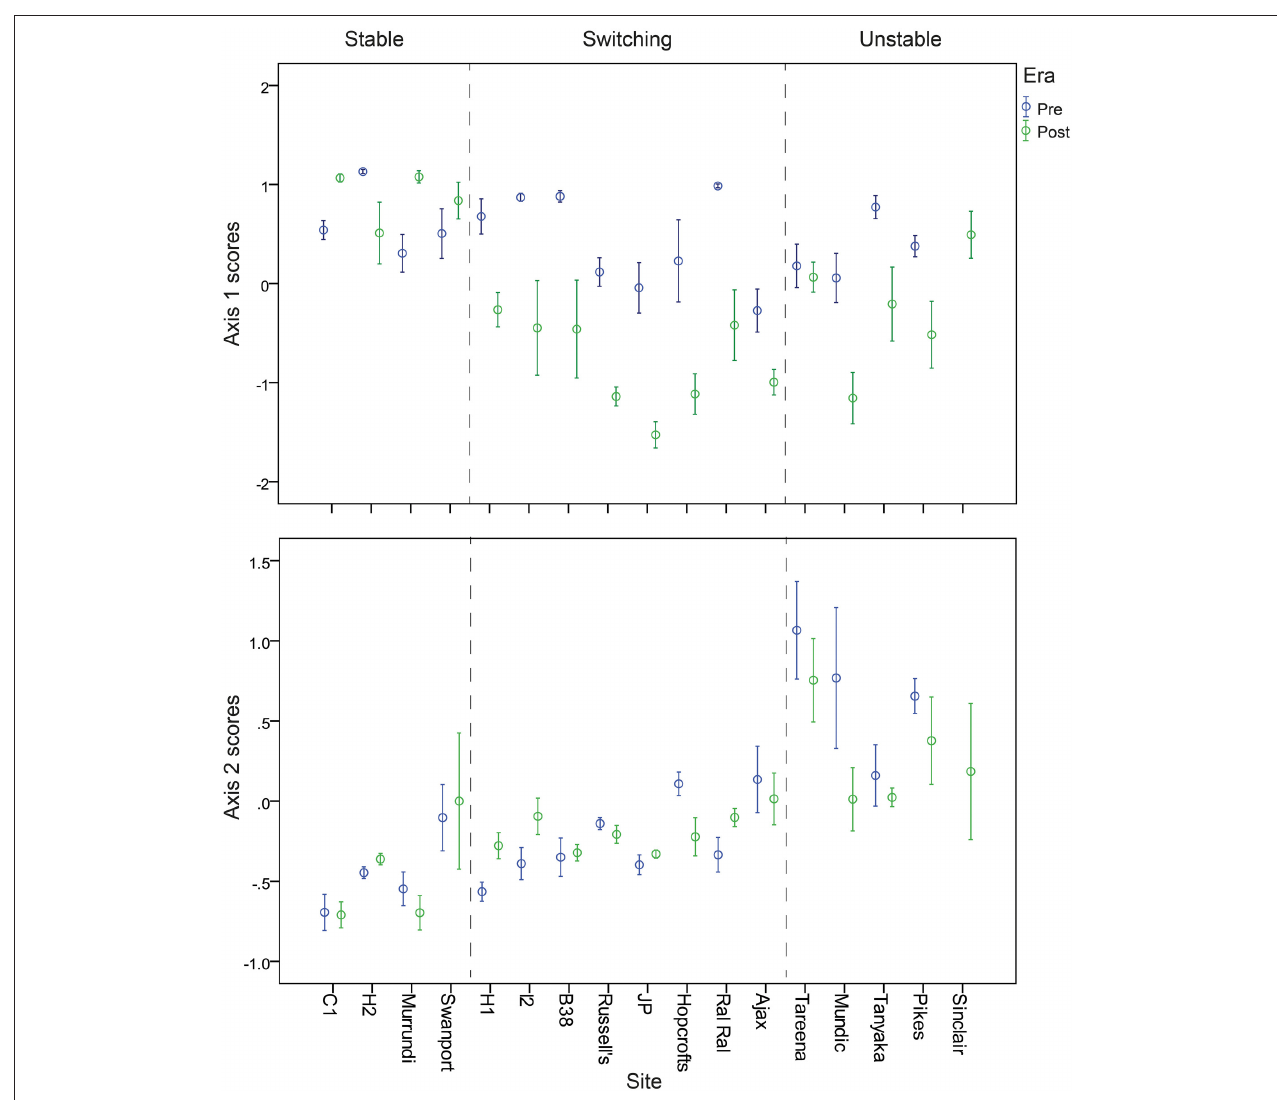
FIGURE 8 | Mean nMDS axis 1 (top) and axis 2 (bottom) scores for subsets of billabong sediment samples from pre- and post-European sediments arranged by billabong and billabong response